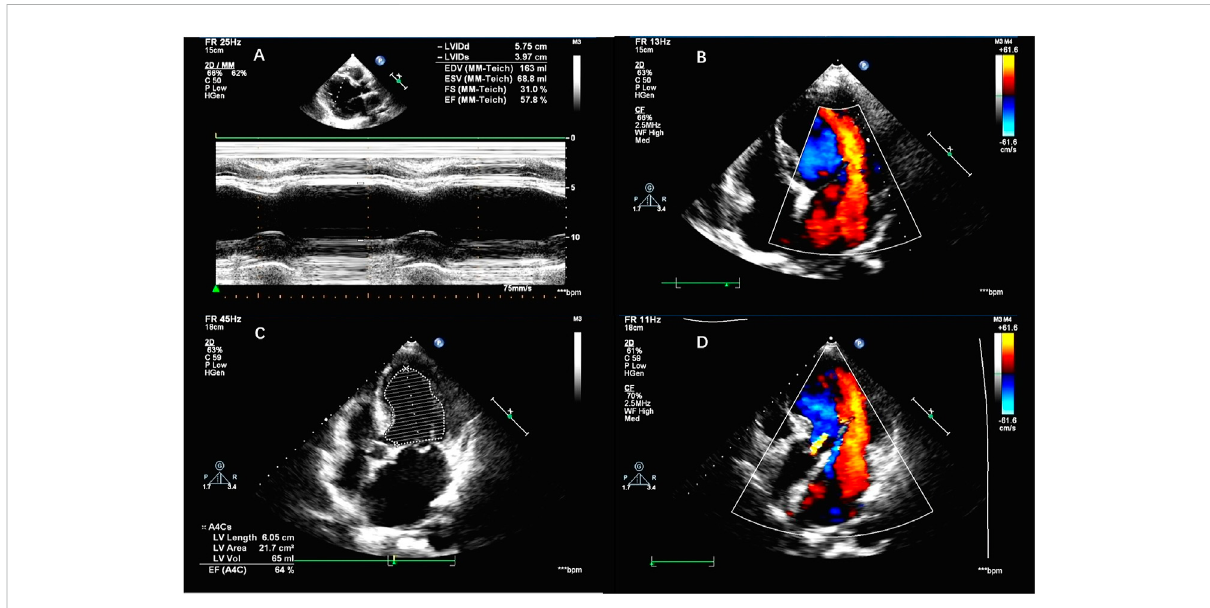
FIGURE 5 (A,B) Echocardiography before the antitumor therapy. (C,D) Echocardiography after the fi ve-course antitumor therapy.